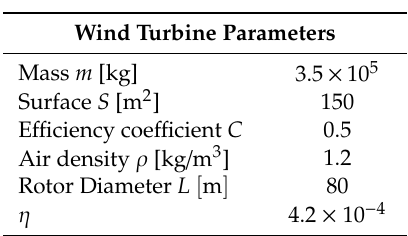
Table 1. Machine